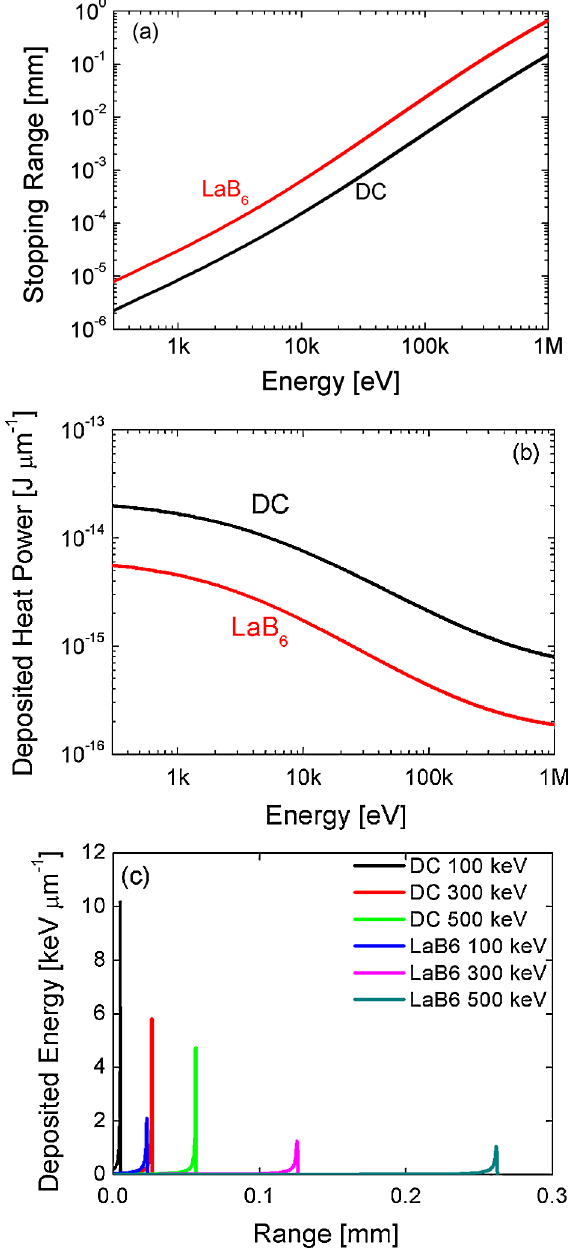
FIG. 5. Temporal evolutions of change in a cathode tempera- ture (a) and current density (b) for DC and LaB the numerical